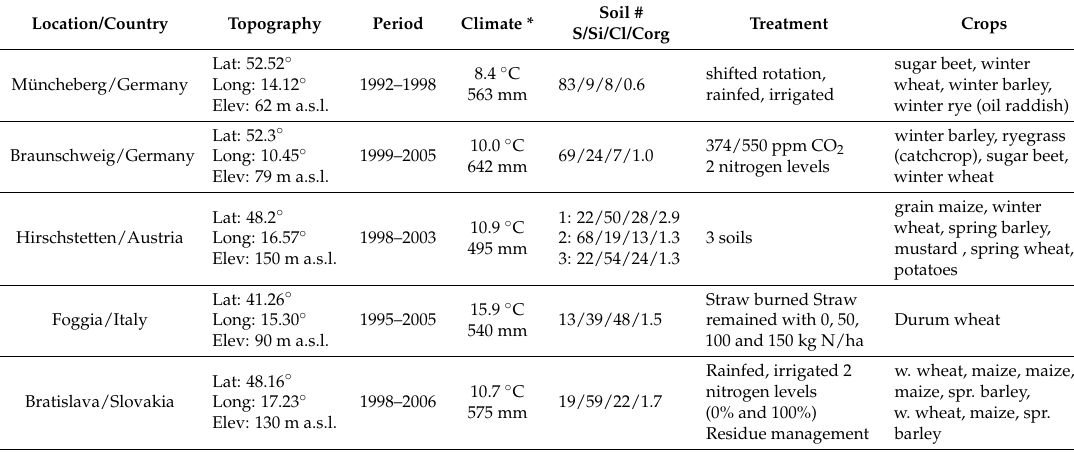
Table 1. Characterization of experimental